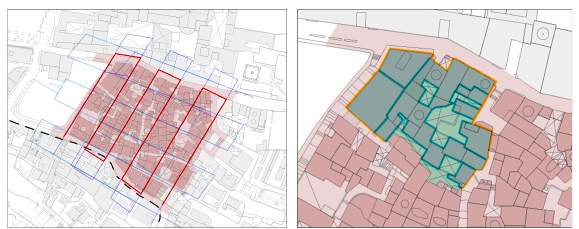
Figure 6: On the left, flight plan set with DJI Phantom 4 Pro for each area, where the 5 missions are marked (one with a 90 ° gimbal angle, the other 4 with 45 ° angle directions). The flights has been set at 34 m high from the ground level. On the right, close range photogrammetry of urban fronts (in orange) with SLR camera and integration with data from DJI Spark for the acquisition of detail of courtyard fronts.